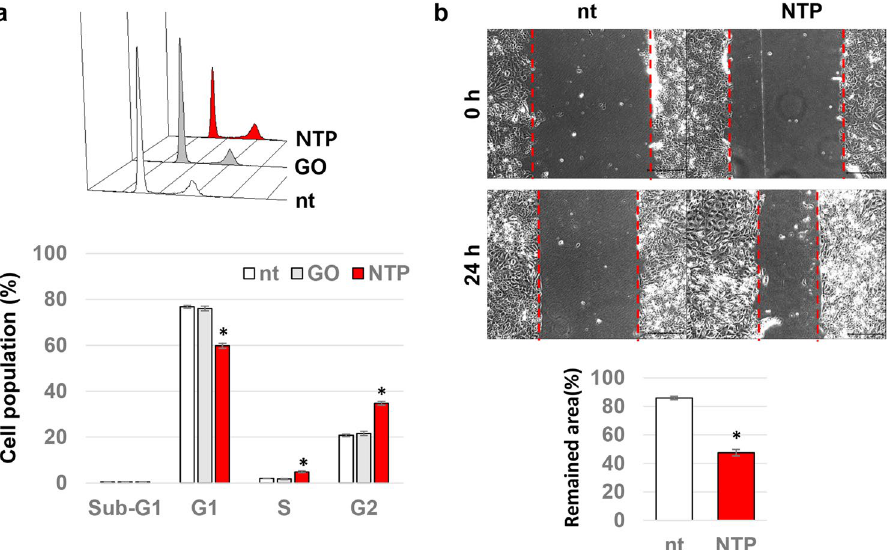
Figure 4. The effect of NTP on cell cycle and wound healing activities of confluent human keratinocytes. ( a ) Confluent HaCaT cells were treated with gas only (GO) or NTP for 5 minutes as indicated. After 6 hours of incubation, the cells were harvested and used for a FACS assay with PI. The percentage of cells in each of the cell cycle phases was calculated as described in the Methods section. Data shown are the averaged percentages from four independent experiments, * p < 0.05. ( b ) The results of the wound healing assay using human primary keratinocytes, HEKa. Five days after seeding, a scratch was made on each culture dish and the cells were treated, or not, with NTP for 5 minutes. Photographs of the scratch were taken at just before and 24 hours after the NTP treatment. Scale bar: 200 μ m. The gap distance were calculated and presented as graph. Data shown are the averaged percentages from four independent experiments, * p <